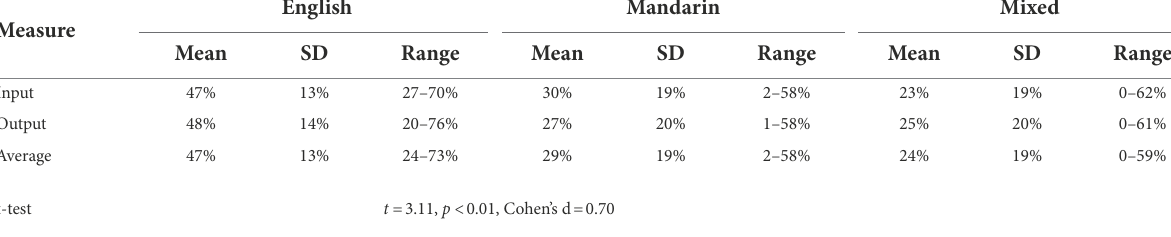
TABLE 1 Means, standard deviations (SD) and range for percent of input and output in each language.